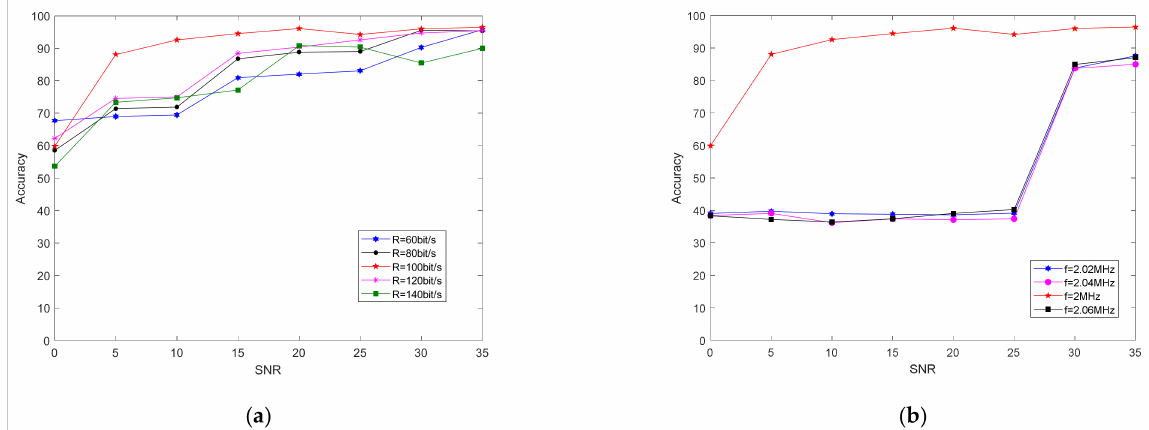
Figure 17. Classification-accuracy results of the proposed method under different signal-to-noise ratio conditions after changing ( a ) the data information rate and ( b ) the carrier frequency of the test